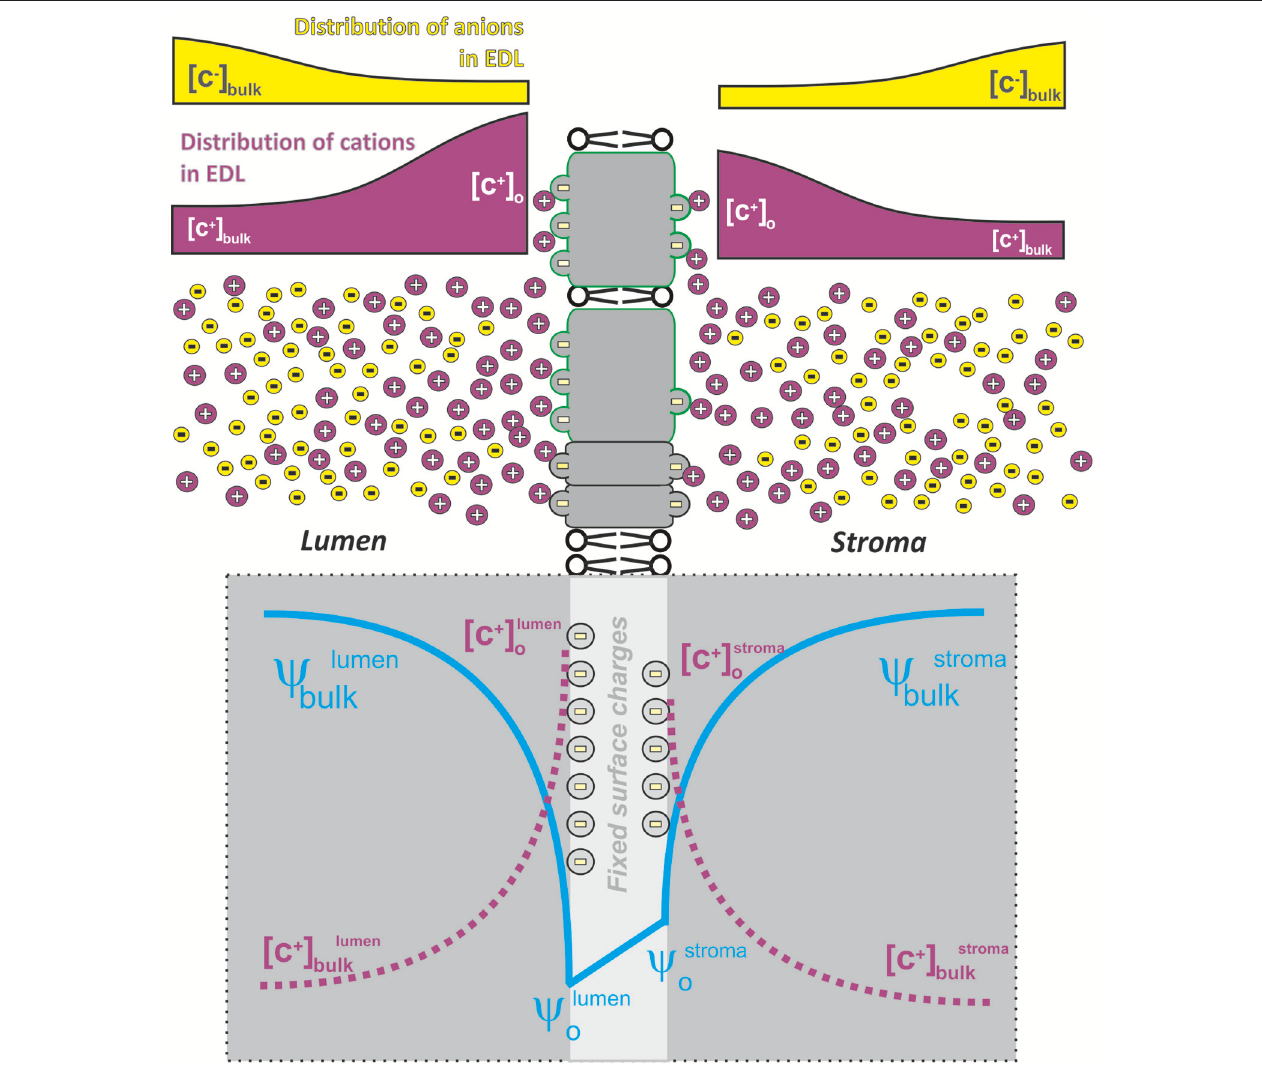
FIGURE 2 | A schematic representation of charge/electrostatic field distribution around thylakoid membranes that forms electric double layer (EDL). Negatively charged amino acid residues form fixed charges on the thylakoid membrane surface that is screened by positive ions (mostly Mg 2 + ) in the lumen as well as in the stroma. The concentration of screening cations decreases with distance from the membrane surface in contrast to that of the anions that are more abundant farther from the negative charges of the membrane. This charge distribution then forms the electric double bilayer (EDL) where the electrical field (see blue line) on the luminal/stromal surface of thylakoid membrane ( ψ o -lumen, ψ o -stroma) is higher than the electrical field measured in the bulk ( ψ bulklumen ; ψ bulkstroma ); there is also a characteristic distribution (see dotted magenta lines) in the concentration of cations at the membrane [C + ] o and in the bulk [C + ] bulk . EDL then represents asymmetric charge distribution of both the anions (e.g., Cl − ) and the cations (K + ; Mg 2 + ) caused by fixed charges on the thylakoid membrane; the concentration of the anions/cations progressively increases/decreases with the distance from the charged thylakoid membrane surface (Barber et al., 1977). The difference between ψ bulk - ψ o is characterized by the extent of electrostatic screening—the higher the electrostatic screening by the ions the lower is the observed difference.